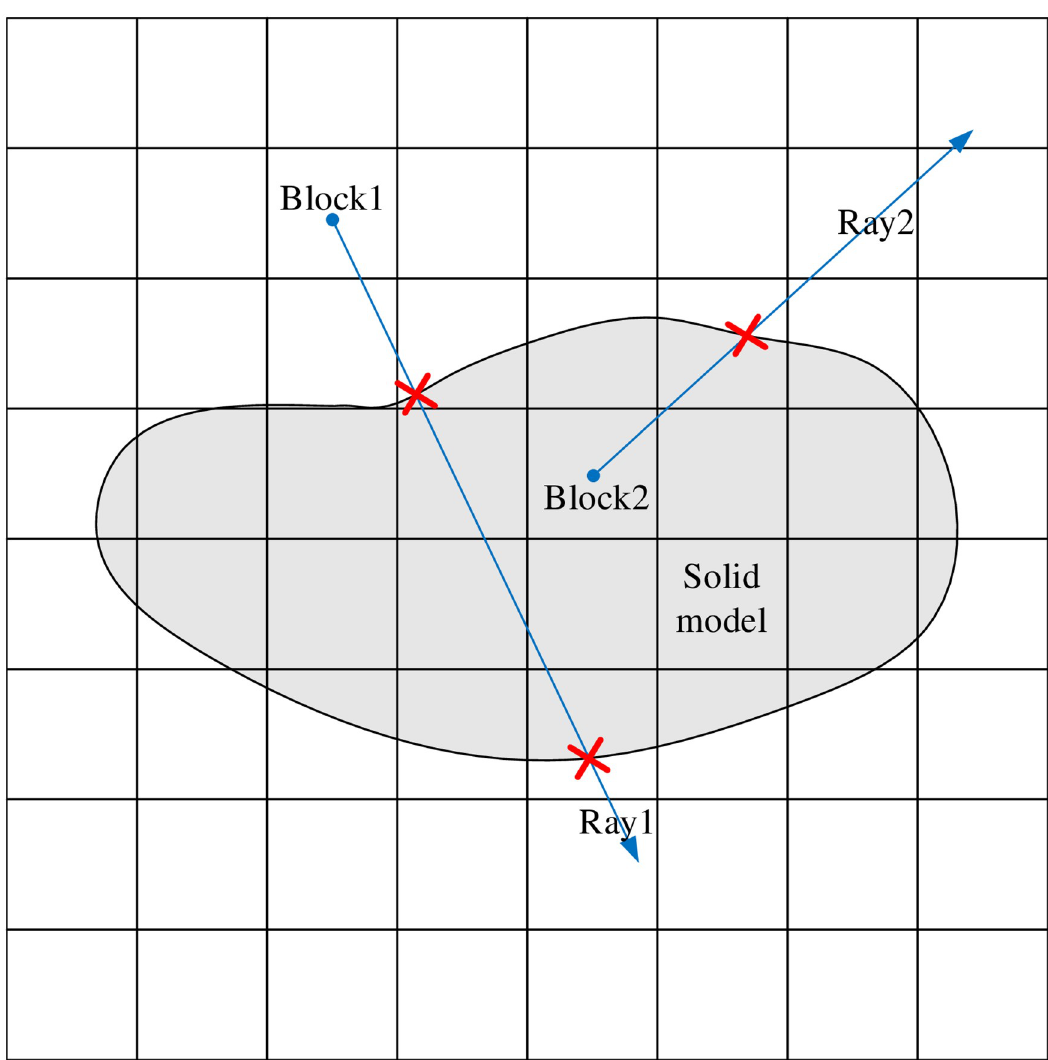
Fig 2. 2D schematic demonstration of the velocity assignment method. Ray1 intersects the solid model twice, which means that Block1 is outside the solid model. Ray2 intersects the solid model once, which means that Block2 is inside the solid model.